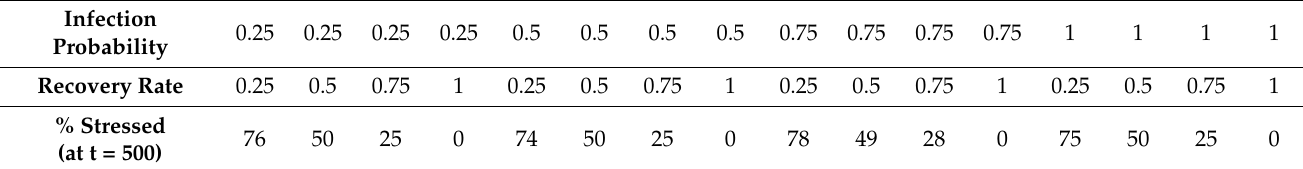
Table 4. Stress prevalence as a function of infection probability and recovery